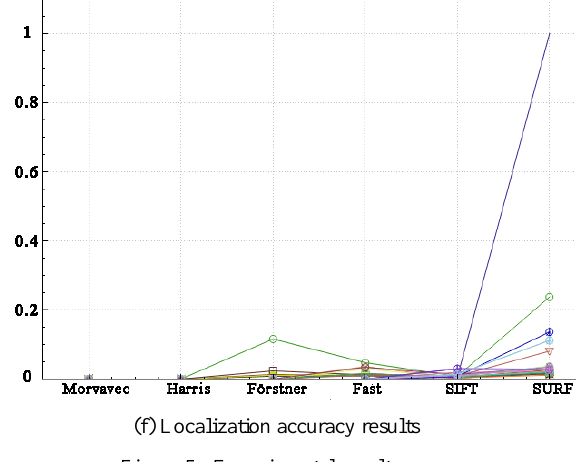
Figure 5. Experimental